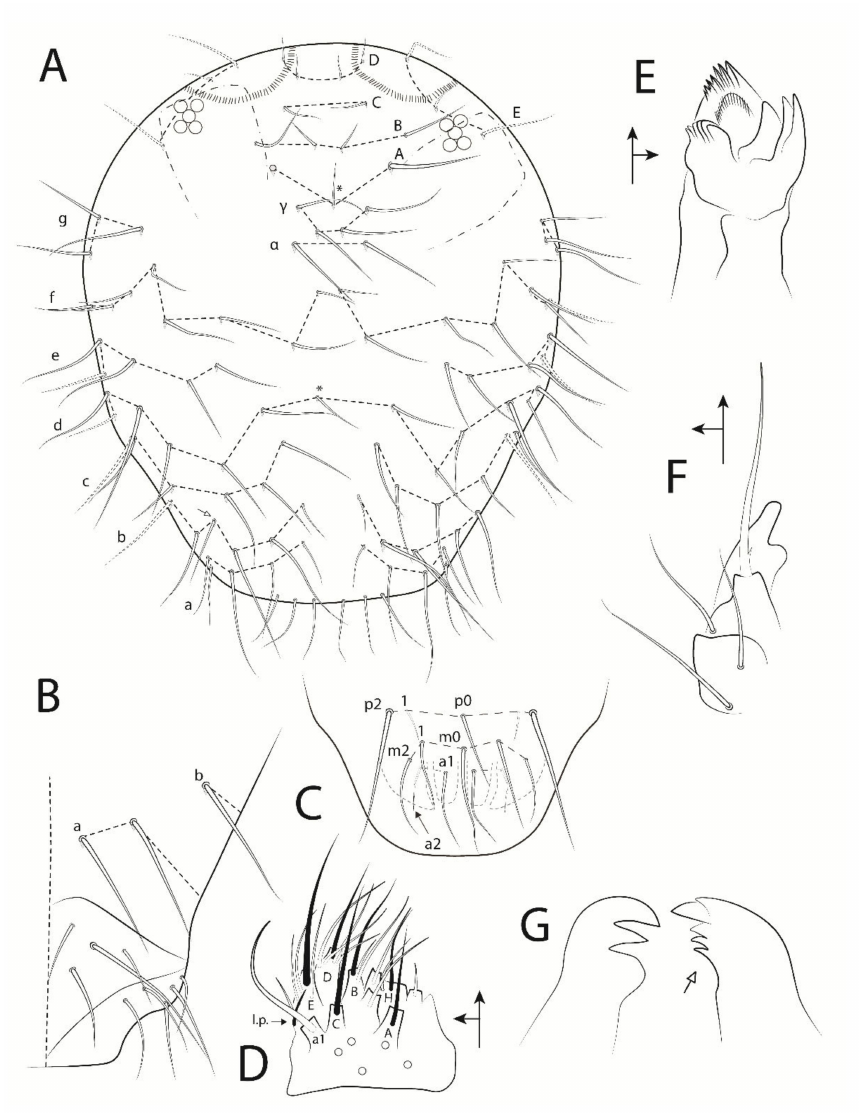
Figure 5. Troglobentosminthurus luridus gen. nov. sp. nov. head: ( A ) anterior head chaetotaxy, Ant. I marked in dotted lines, white arrow marks a chaeta present or absent, asterisks mark unpaired central chaetae; ( B ) right side of the posterior (ventral) head chaetotaxy, including post-labial, labial basomedial and basolateral chaetae; ( C ) labral chaetotaxy; ( D ) left labial palp; ( E ) right maxilla capitulum; ( F ) left maxillary outer lobe and sublobal plate; ( G ) incisive (apical) teeth of the mandibles, white arrow marks a tooth in the right mandible which can be